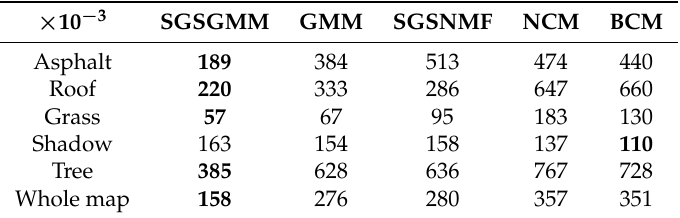
Table 3. Abundance errors for Gulfport dataset.